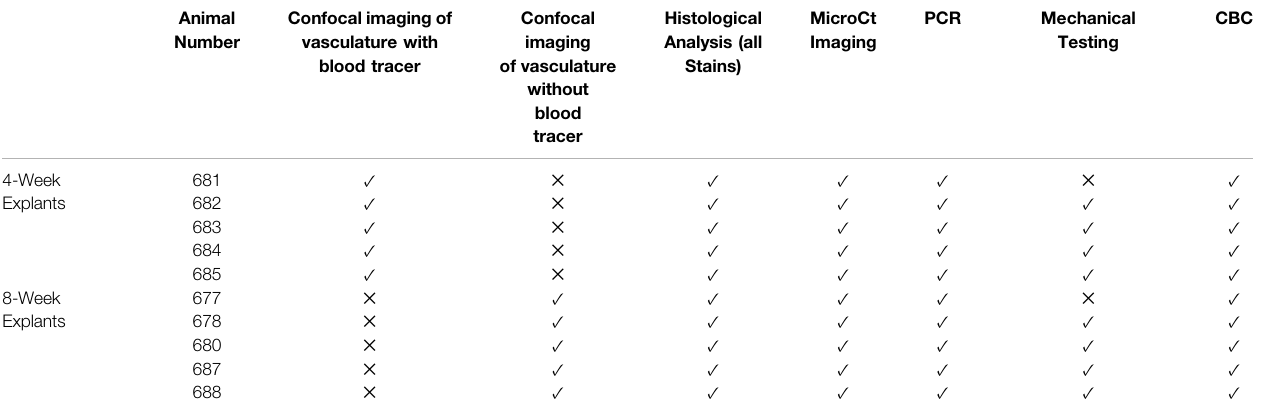
TABLE 4 | Analysis performed on each animal. Check mark indicates analysis was performed X indicates analysis was not performed.